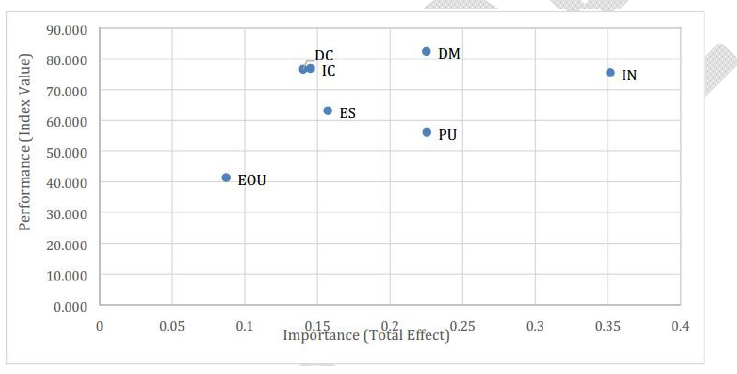
Fig. 4. IPMA Results of Semantic Web Adoption as Target